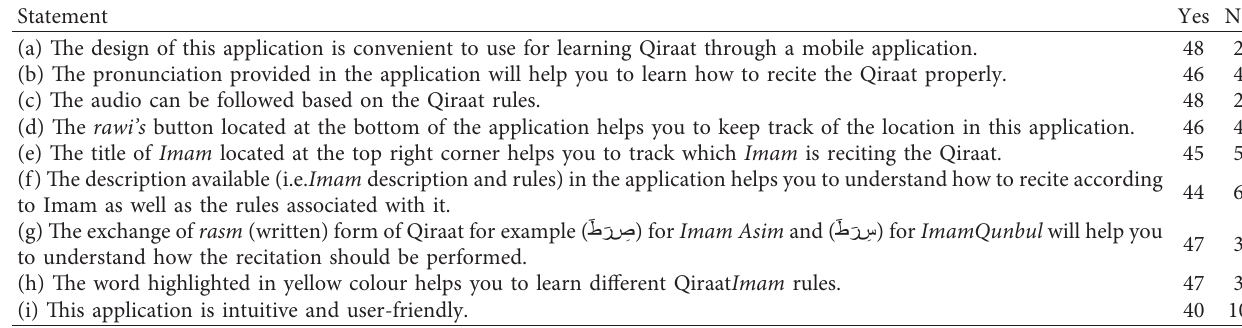
Table 3: Statement on research question two.